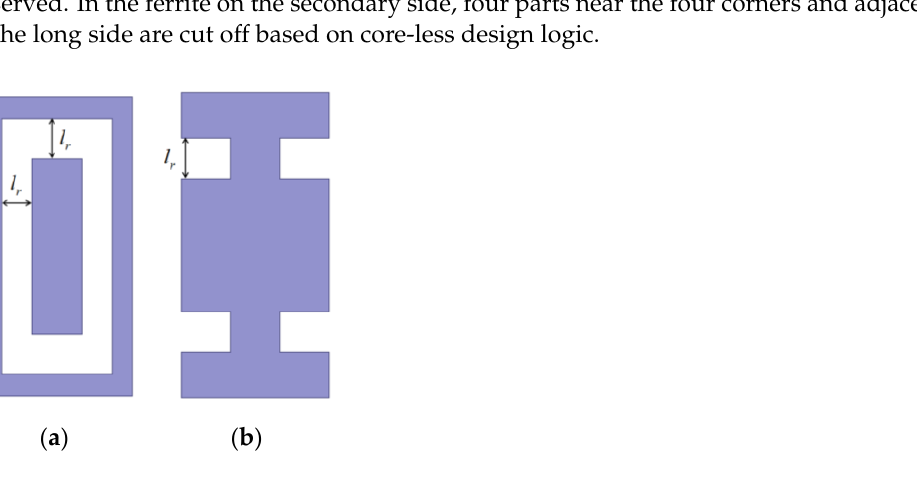
Figure 13. Optimization method on the ferrites applied in square-shaped coupler: ( a ) Primary core; ( b ) Secondary core.